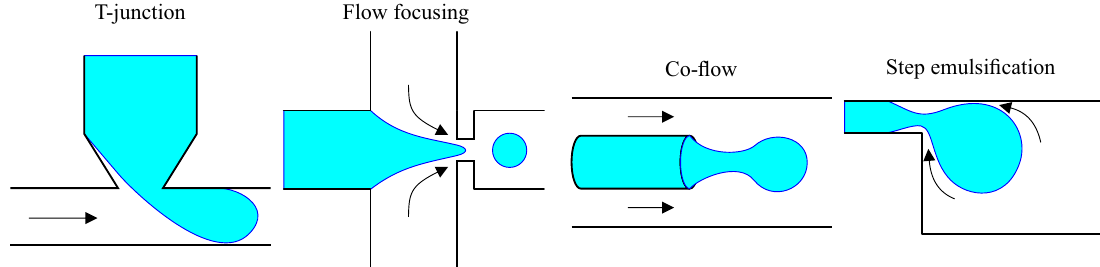
Figure 2. Schematic representation of the most popular droplet generation methods. Black arrows indicate the flow direction of the continuous